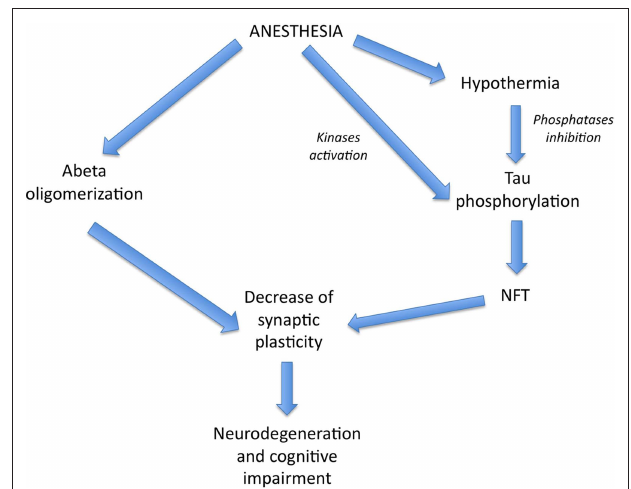
Figure 1 | Theoretical pathways by which anesthesia could affect AD pathogenesis. Volatile anesthetics could promote A β pathology and NFT formation, both leading to a decrease in synaptic plasticity and neurodegeneration. Interestingly, anesthesia could enhance tau phosphorylation, either directly, through kinases activation, or indirectly, through hypothermia-induced phosphatases